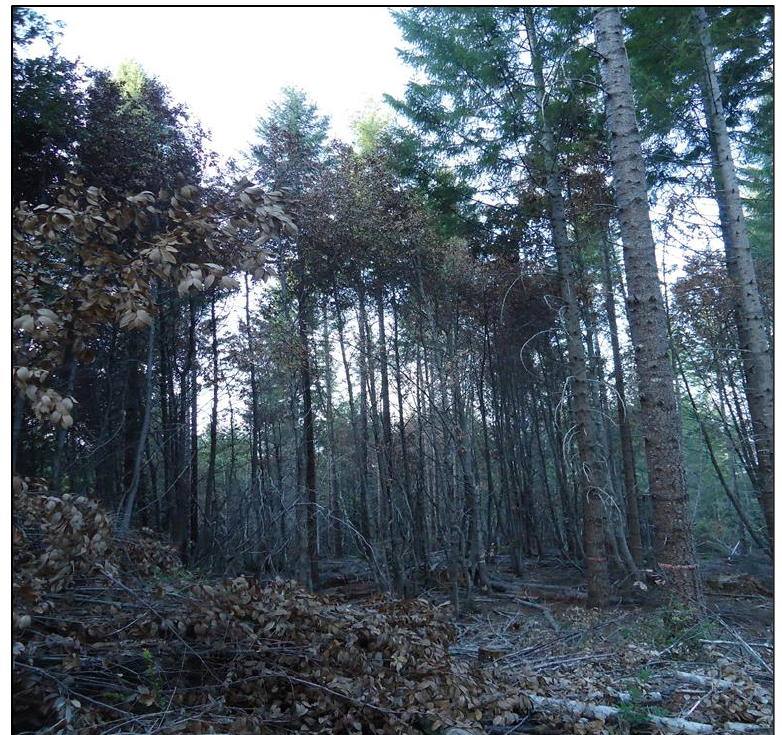
Figure 2. Prolonged retention of dead foliage on hardwoods standing dead after frill treatment and down hardwoods cut by feller buncher during partial harvest of Douglas-fir 12 months earlier at Lupton Creek.